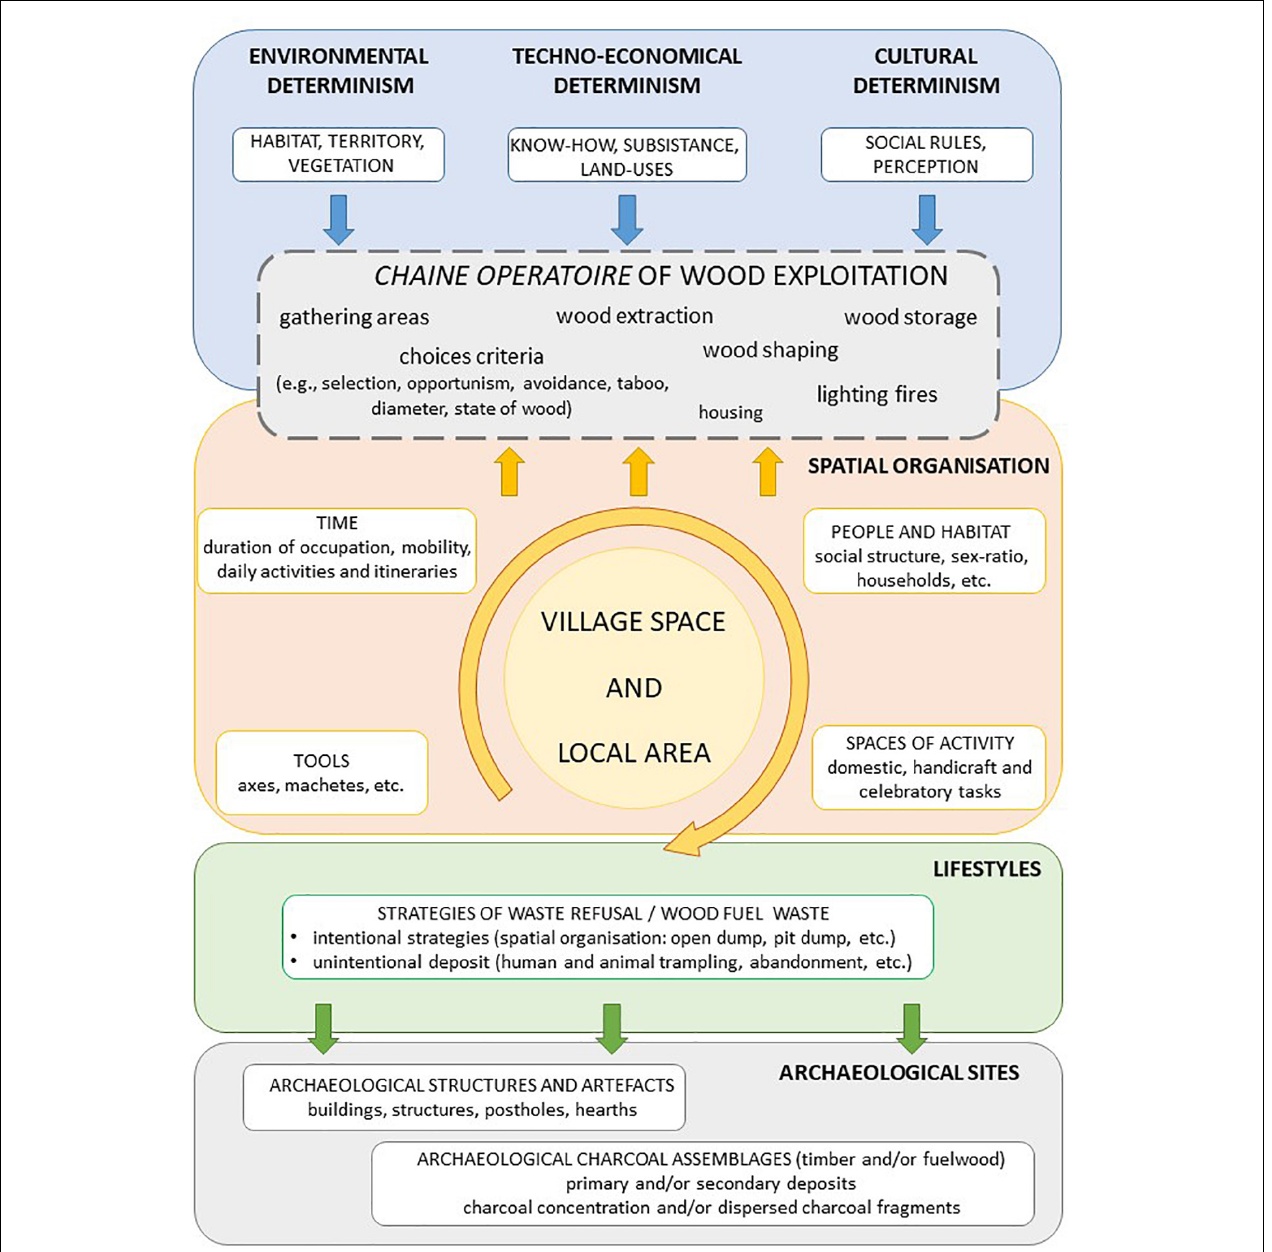
FIGURE 1 | Archeological charcoal fragments as valuable artefacts reflecting socio-economic organization and